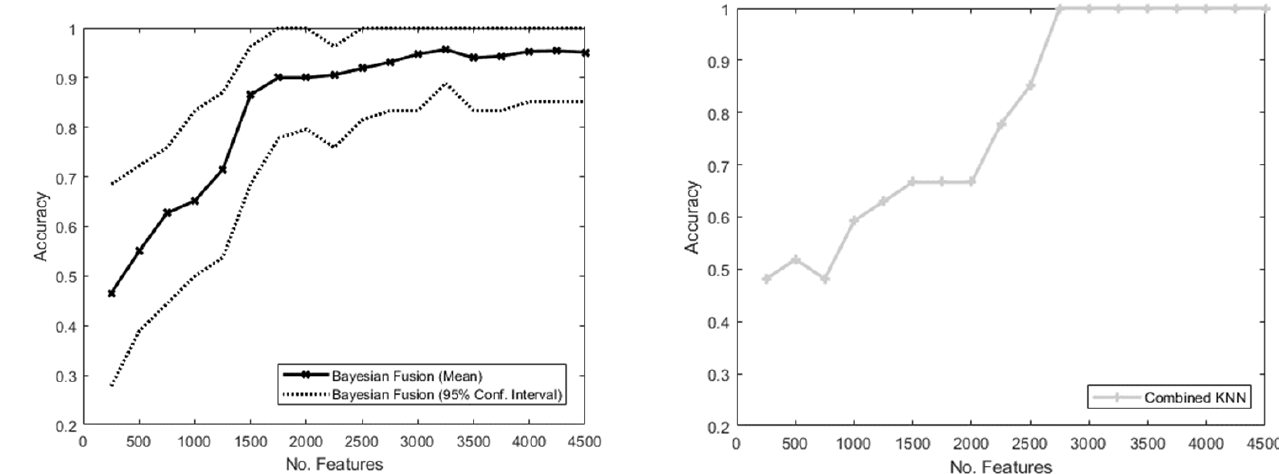
Figure A1. Example graphs of randomly selected volunteers to show the accuracy across the number of features selected in the Bayesian Fusion method with all sensors included. The Bayesian Fusion algorithm has confidence intervals, as its performance depends on how the training data is subdivided. The Combined KNN method does not have confidence intervals, as all the sensors are included and there is no subdivision of the training data, so its performance is entirely reproducible.